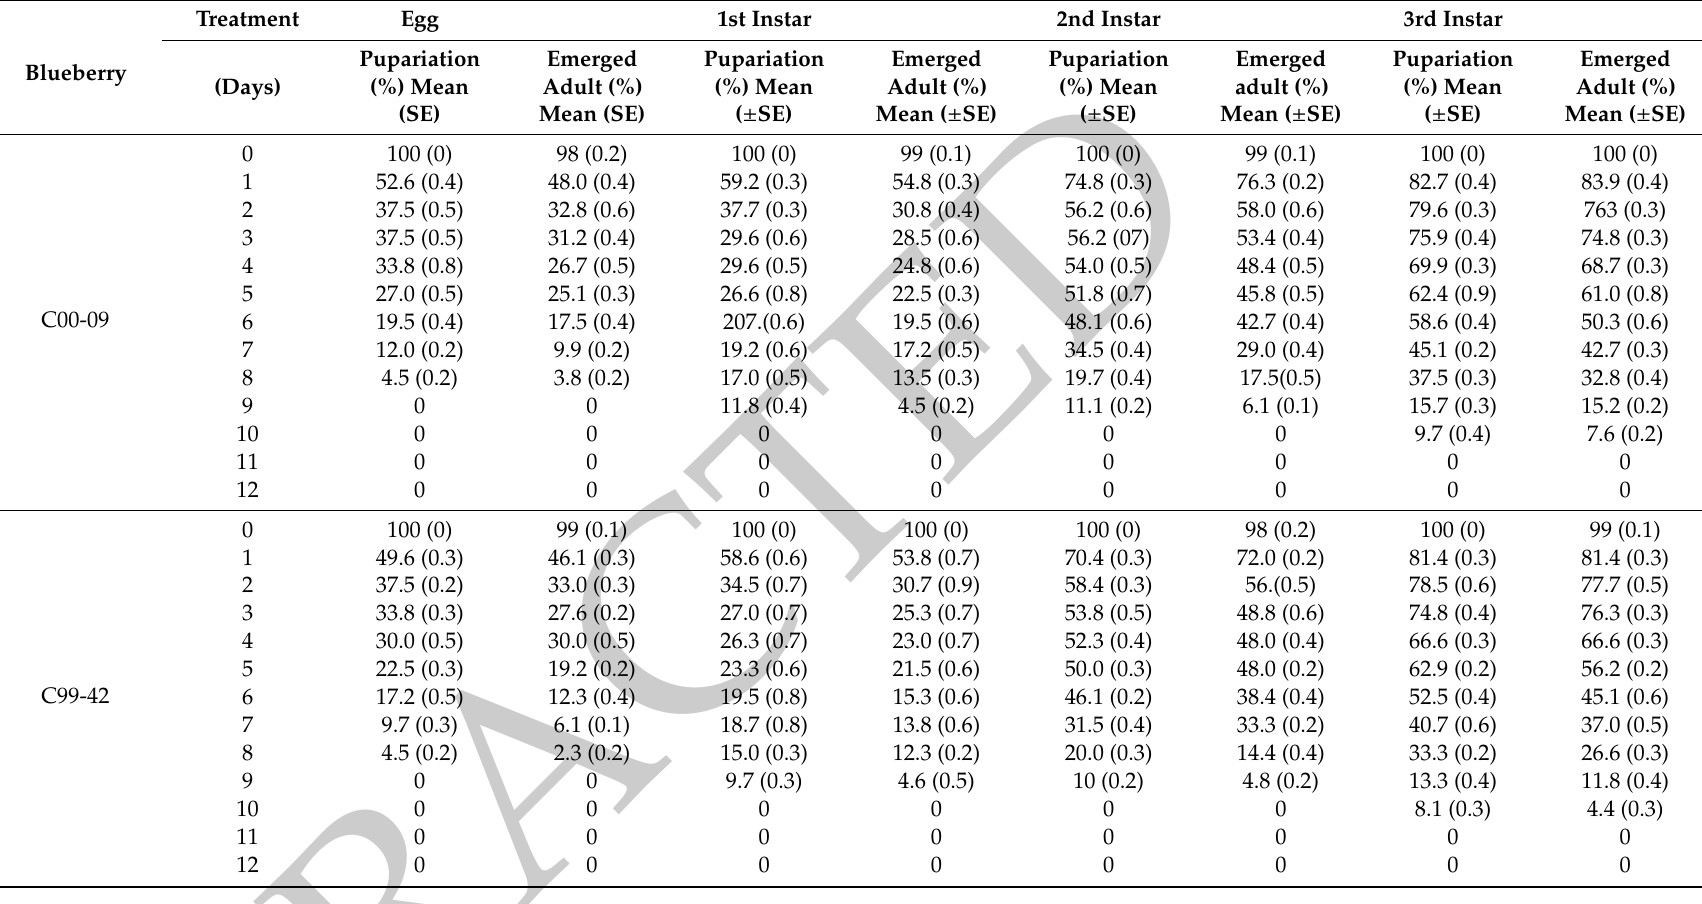
Table 2. Pupariation rates and emerged adults of four immature stages of C. capitata after exposure to cold treatment (1.0 ± 0.2 ◦ C) for 12 days in two